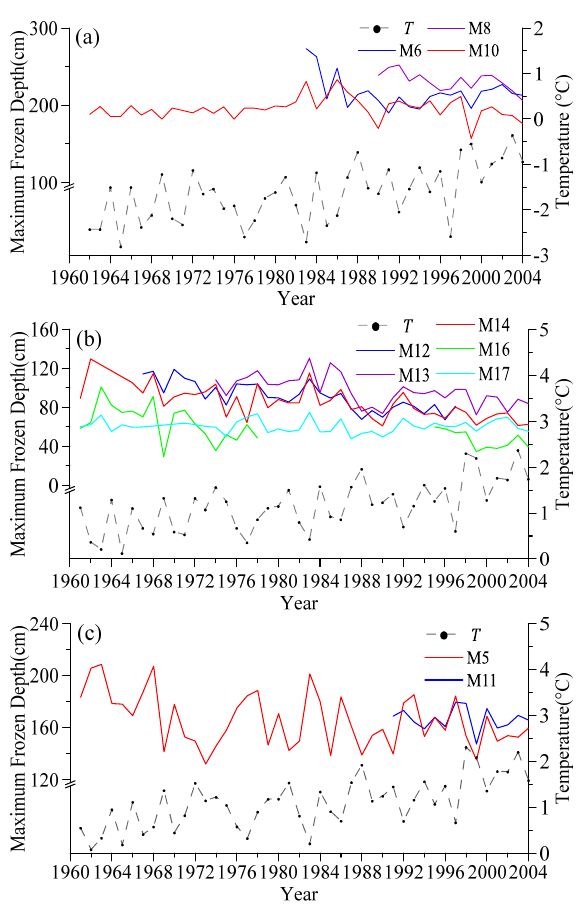
Figure 2. Change in the maximum frozen depth (MFD) and annual mean temperature of ( a ) Jimai (JM), ( b ) Maqu (MQ), and ( c ) Tangnaihai (TNH) sub - basins.